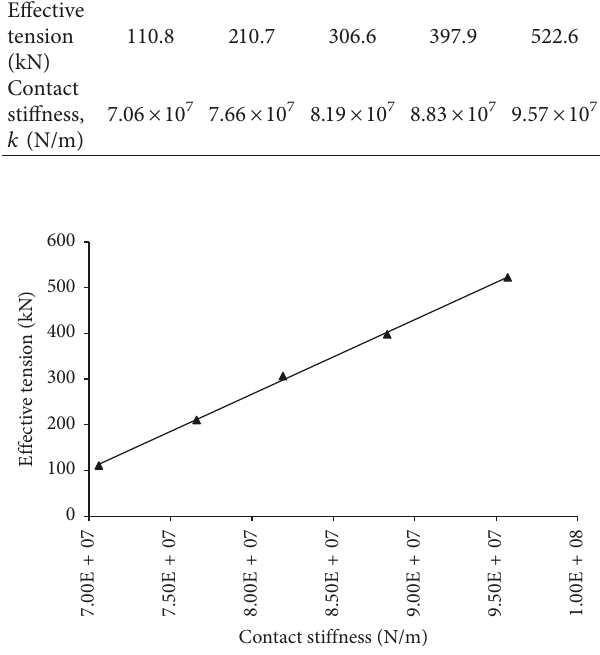
Table 3: Values of contact stiffness k corresponding to the effective tensions of the experimental model.